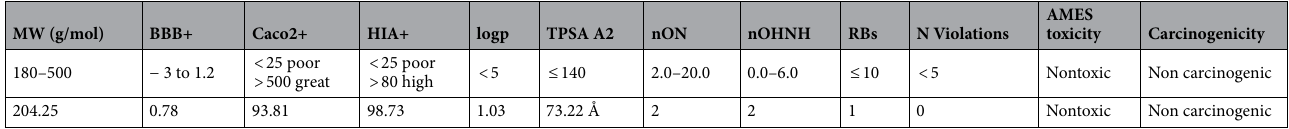
Table 4. List of ADME and physicochemical properties of 5B2T. MW: molecular weight; BBB+ : blood–brain barrier; Caco2 + , Caco-2: Permeability; HIA + : %Human Intestinal Absorption; logp: logarithm of partition coefficient between n-octanol and water; TPSA2: topological polar surface area; nON: number of hydrogen bond acceptors; nOHNH: number of hydrogen bond donors; RBs: number of rotatable